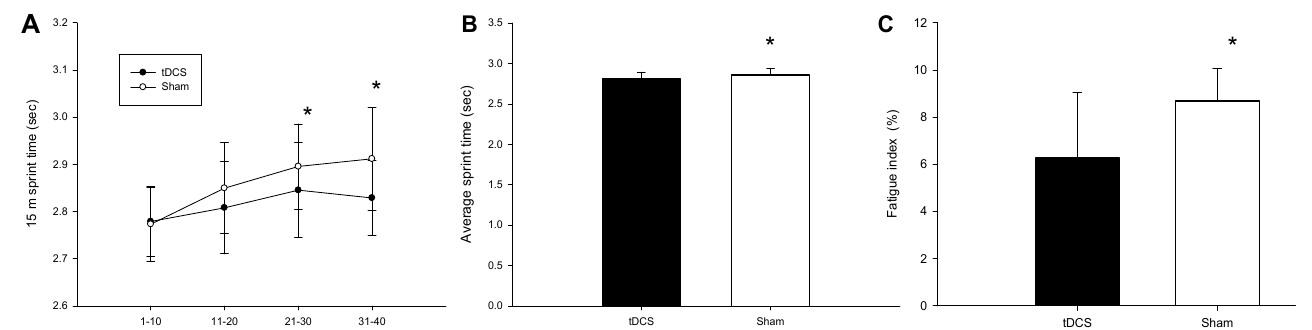
Figure 3. The completed time of sprinting on 1–10, 11–20, 21–30, and 31–40 m ( A ) Average time of sprinting ( B ) and fatigue index ( C ). * mean a significantly different between tDCS group and Sham group. Values are mean ± SD.